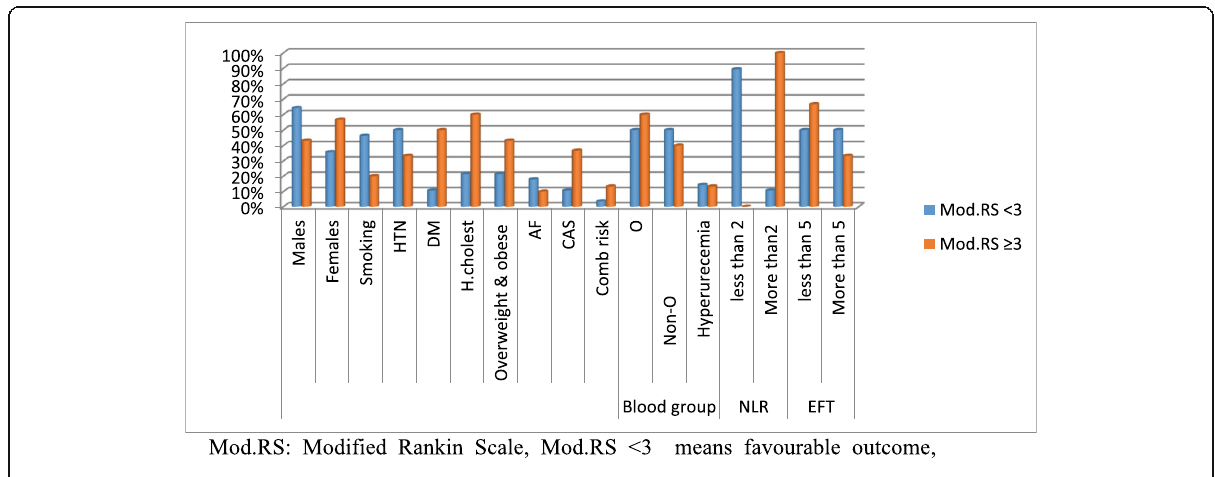
Fig. 1 Stroke outcome (MRS) in relation to clinical data and EFT and NLR. Mod.RS, Modified Rankin Scale; Mod.RS < 3, means favorable outcome